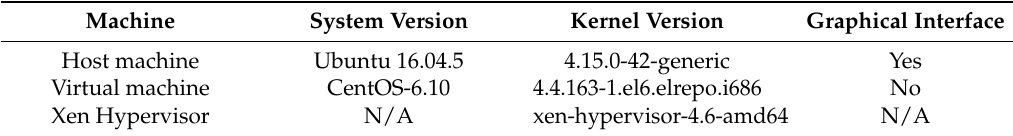
Table 4. Operating system environment.